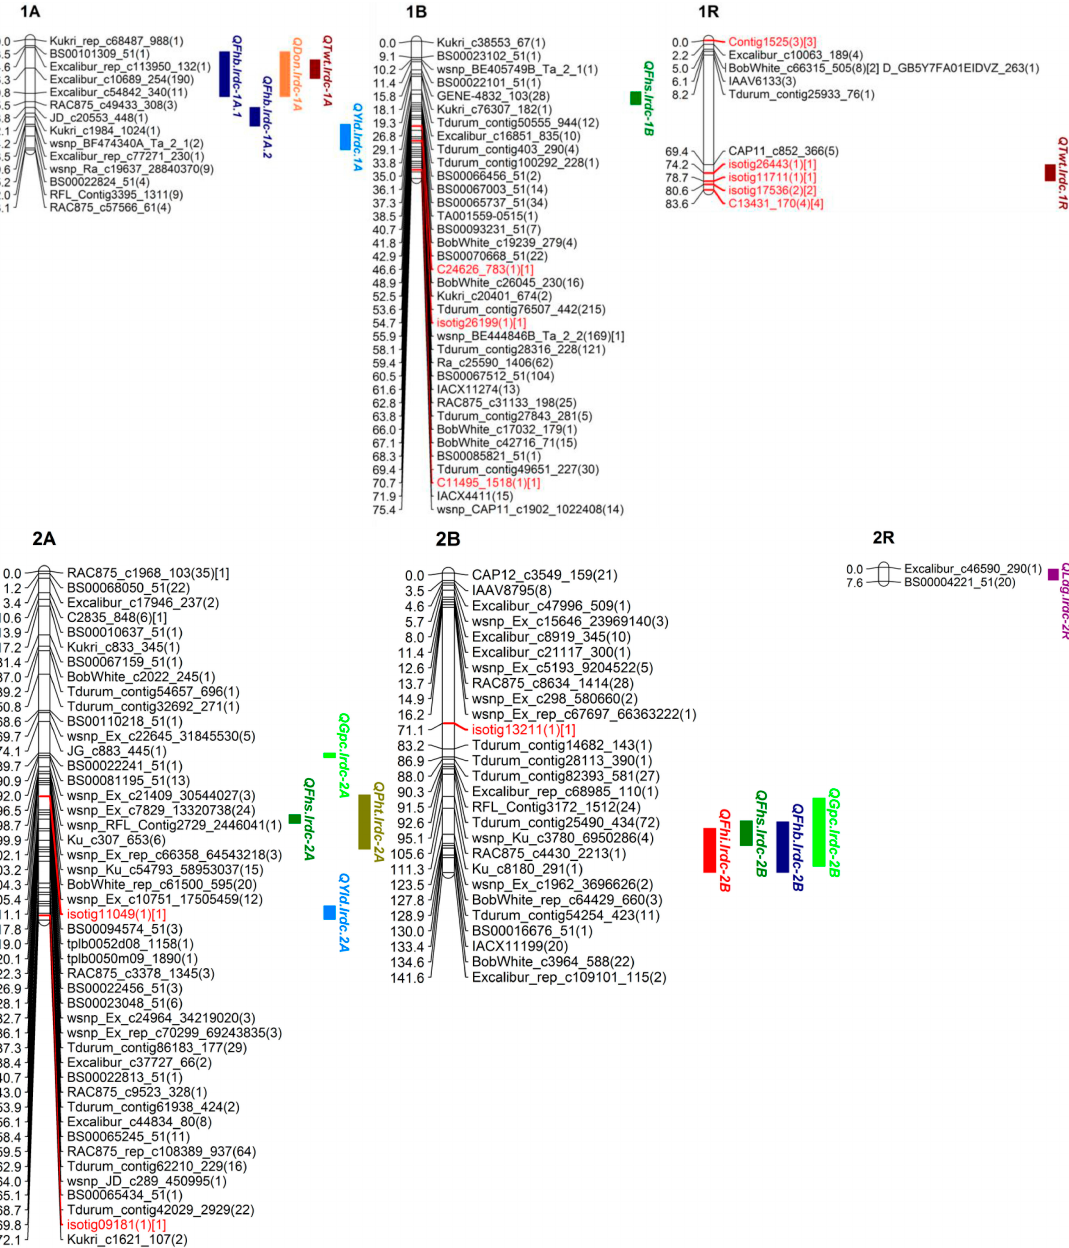
Figure 4. Homoeologous groups 1 and 2 single nucleotide polymorphism (SNP) map of TMP16315/AC Ultima triticale DH population. Loci on chromosome maps are represented by unique markers. Marker names in black and red colors represent genomic regions largely dominated by SNPs derived from wheat genomes A/B/D and rye genome R, respectively. Numbers in round brackets represents total number of SNPs at the locus and number in square brackets represents SNPs derived from R genome. The quantitative trait loci (QTL) for different traits are given on the right side of maps.